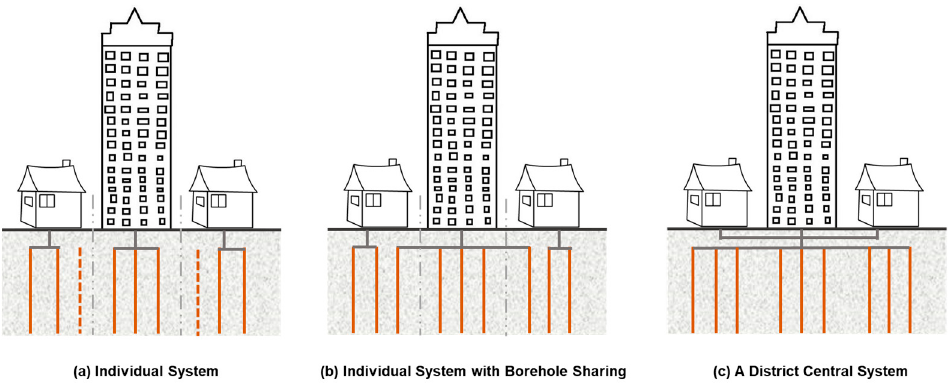
Figure 1. Individual ( a ) and sharing ( b , c ) ground source heat pump (GSHP) systems for a